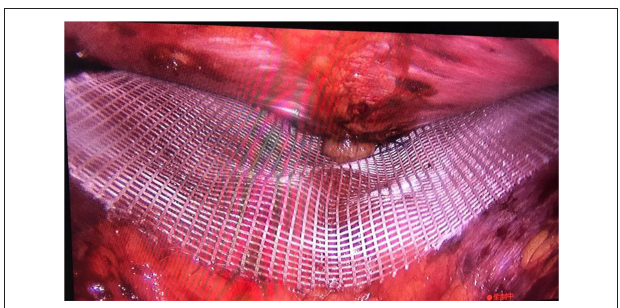
FIGURE 2 | Method 1 of patch placement.